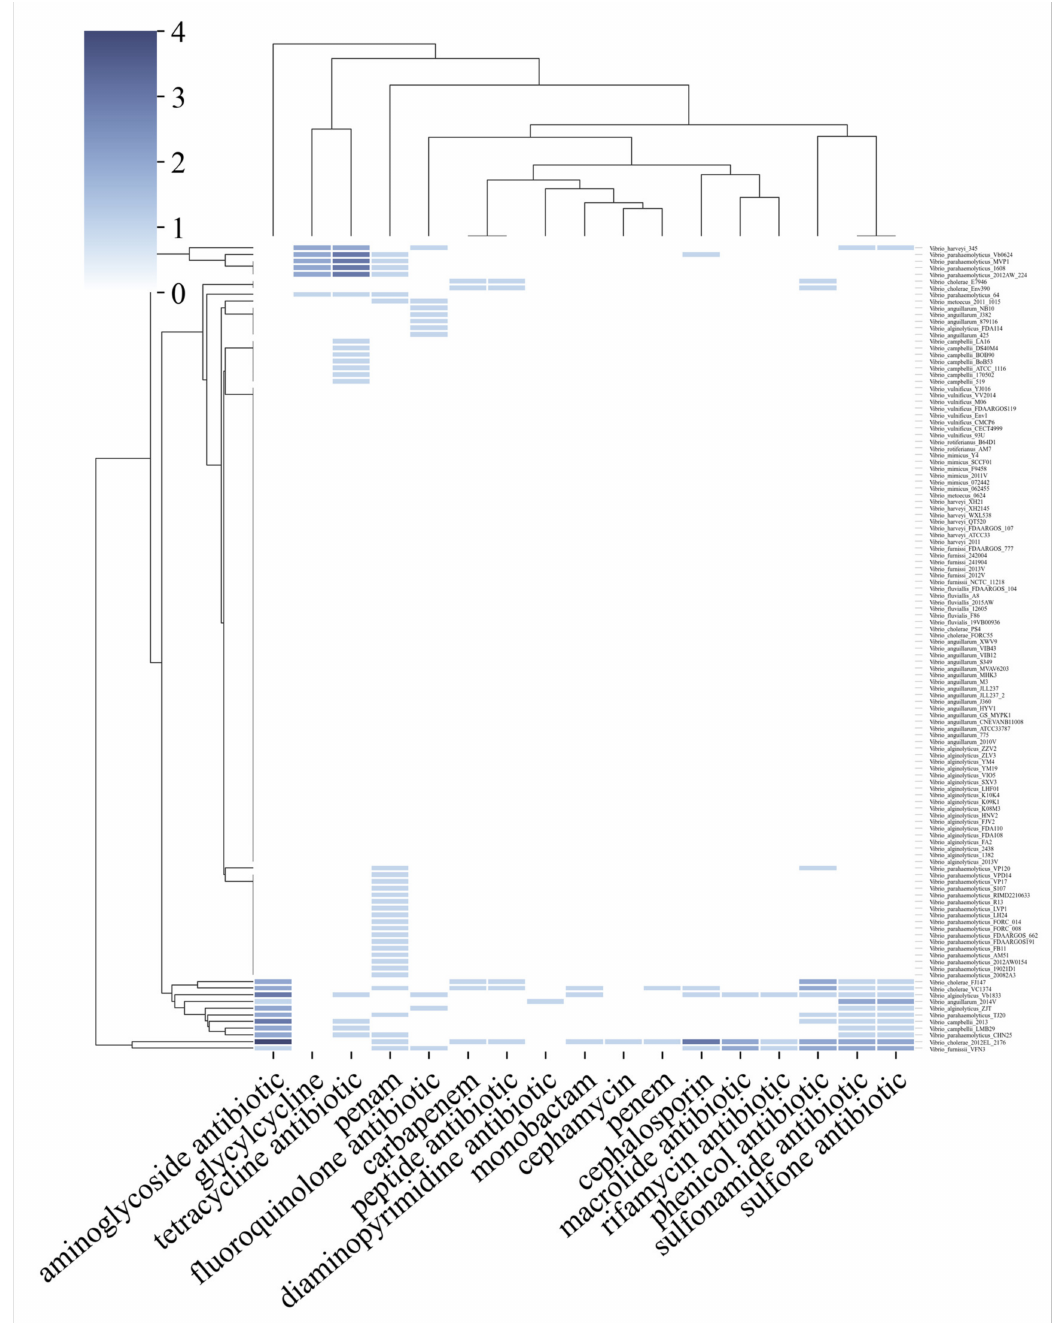
Figure 3. Clustering resistance genes from the PRAP tool using the CARD database. On the right are the genomes of each species used, below are the antibiotic classes, and on the left and above are the cluster formation process based on antibiotic resistance. From 0 to 4 indicates the number of genes associated with the antibiotic